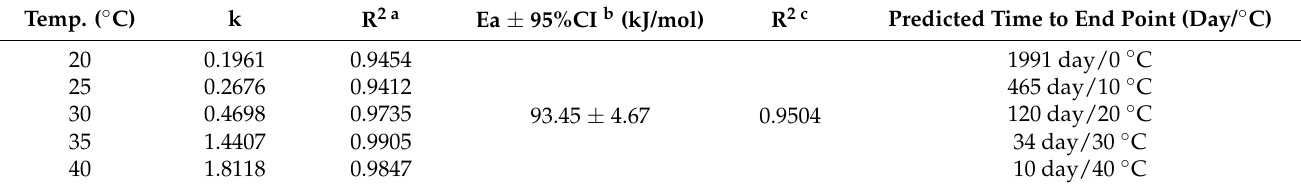
Figure 4. Response of the sensory evaluation of “boba” balls stored under different conditions.